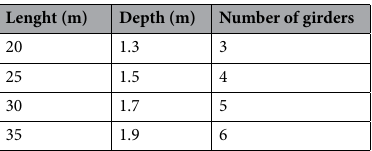
Table 1. Variables analysed in the parametric